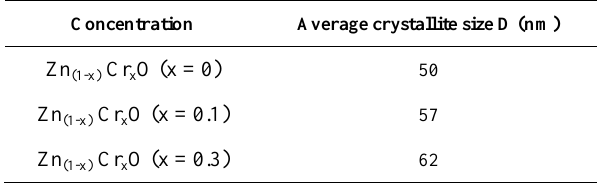
Table 1. Average crystallite size of Zn (1-x) Cr x O (x = 0, 0.1, 0.3)